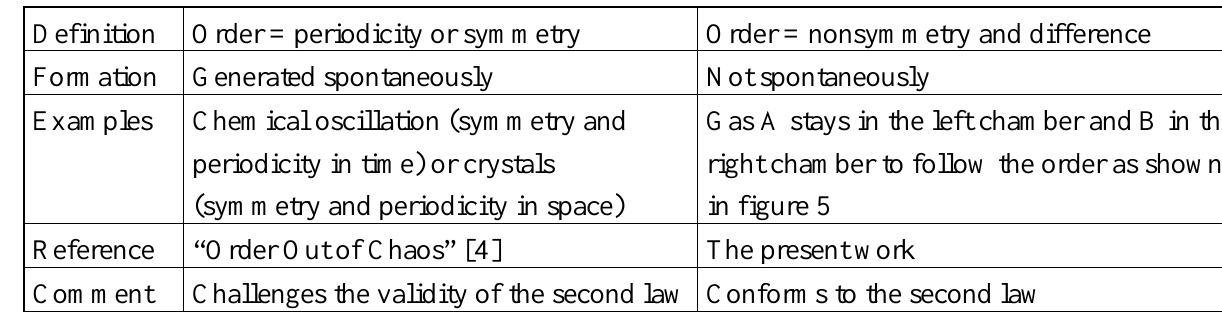
Table 1. Two definitions of